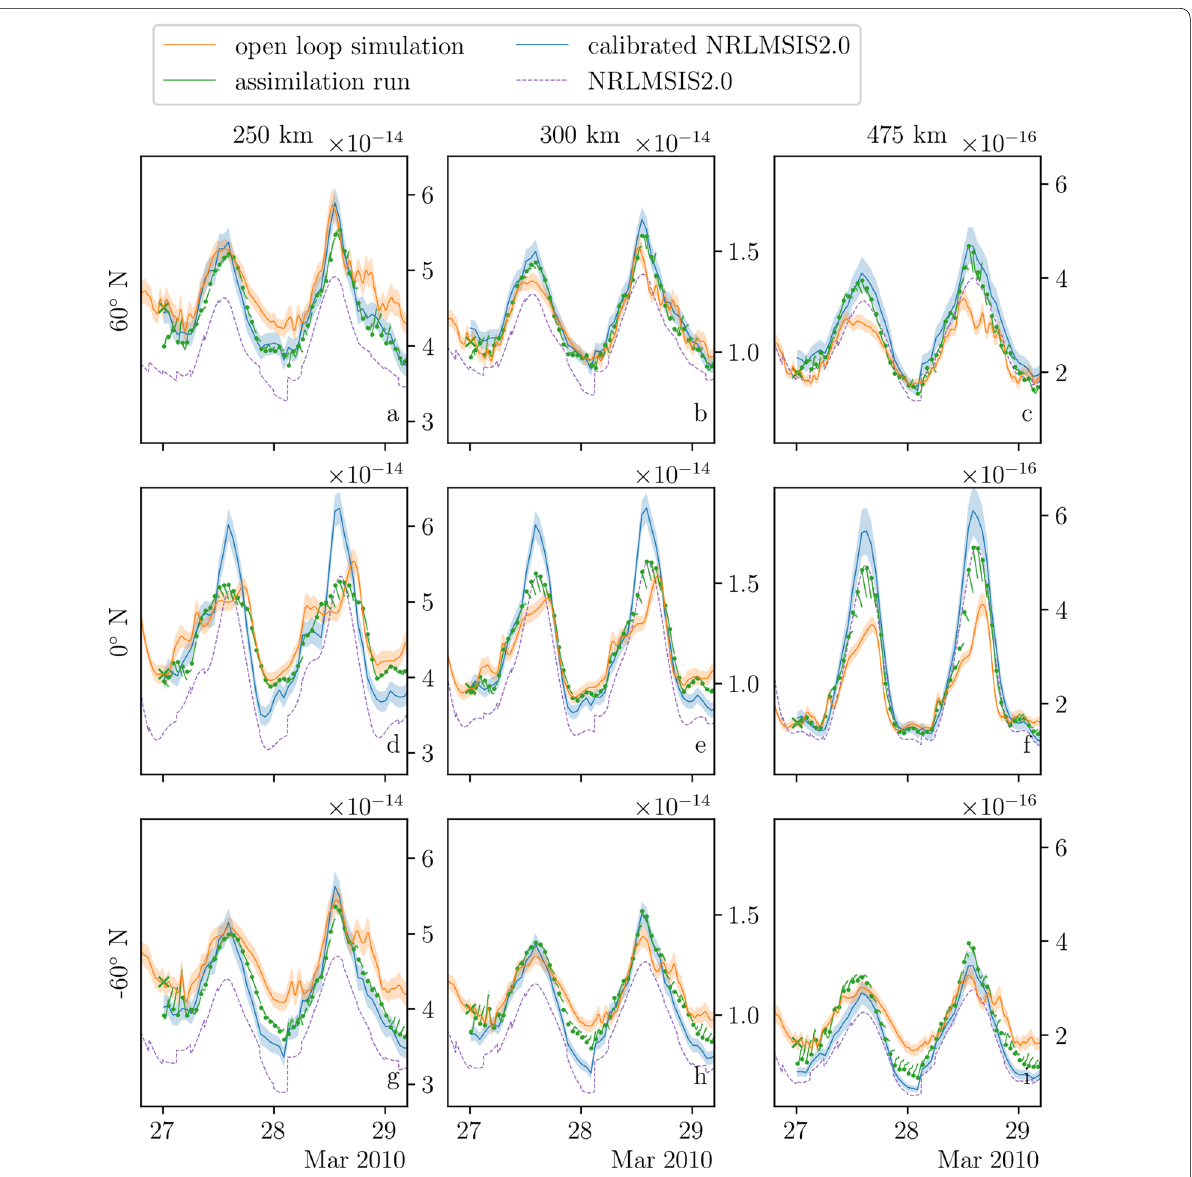
Fig. 6 Each panel contains time series of neutral density (cid:31) g cm 3 (cid:30) for different cells of the data grid . Each row corresponds to a geocentric latitude and each column to an ellipsoidal height. The longitude is always 0 ◦ E . The panels of each column share the same y-axis. The errors bands show the standard deviation. This figure shows the first 2 days of the experiment with quiet geomagnetic